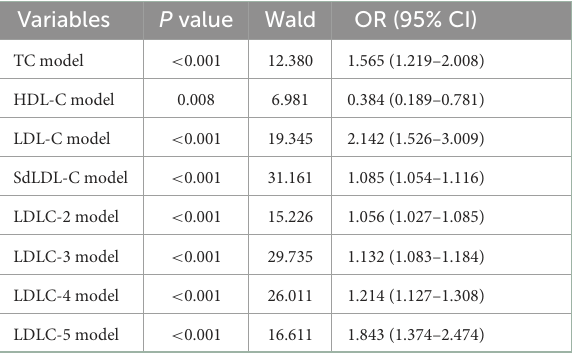
TABLE 4 Multivariate logistic regression analysis of the independent correlation between blood lipids and CAD risk, by adjusting clinical risk factors.